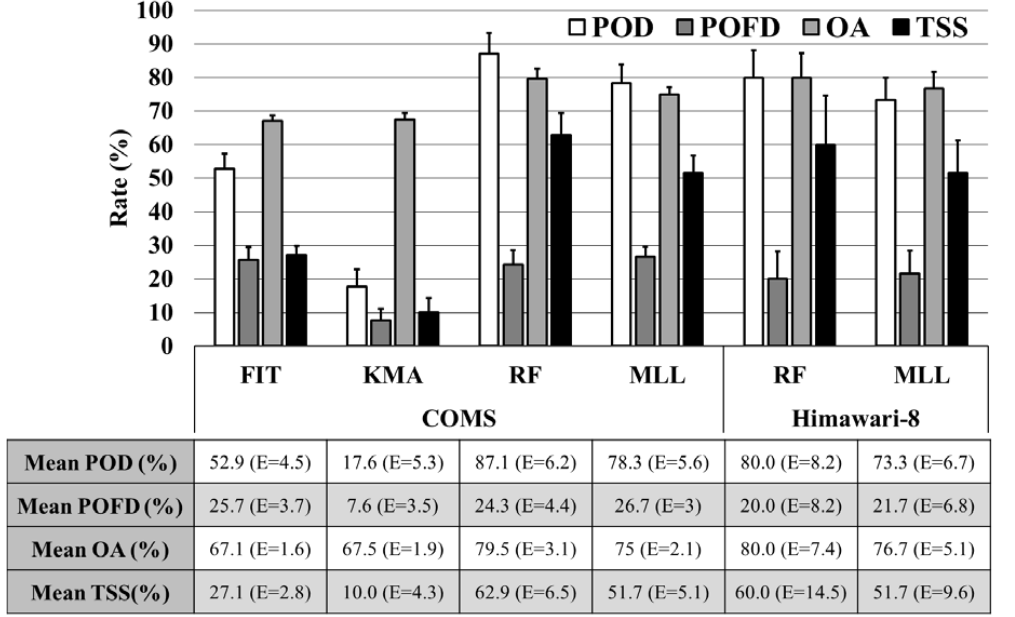
Figure 4. Accuracy assessment results of each icing detection model. (POD = Probability of detection; POFD = Probability of false detection; OA = Overall accuracy; TSS = True skill statistics; E = Standard error).